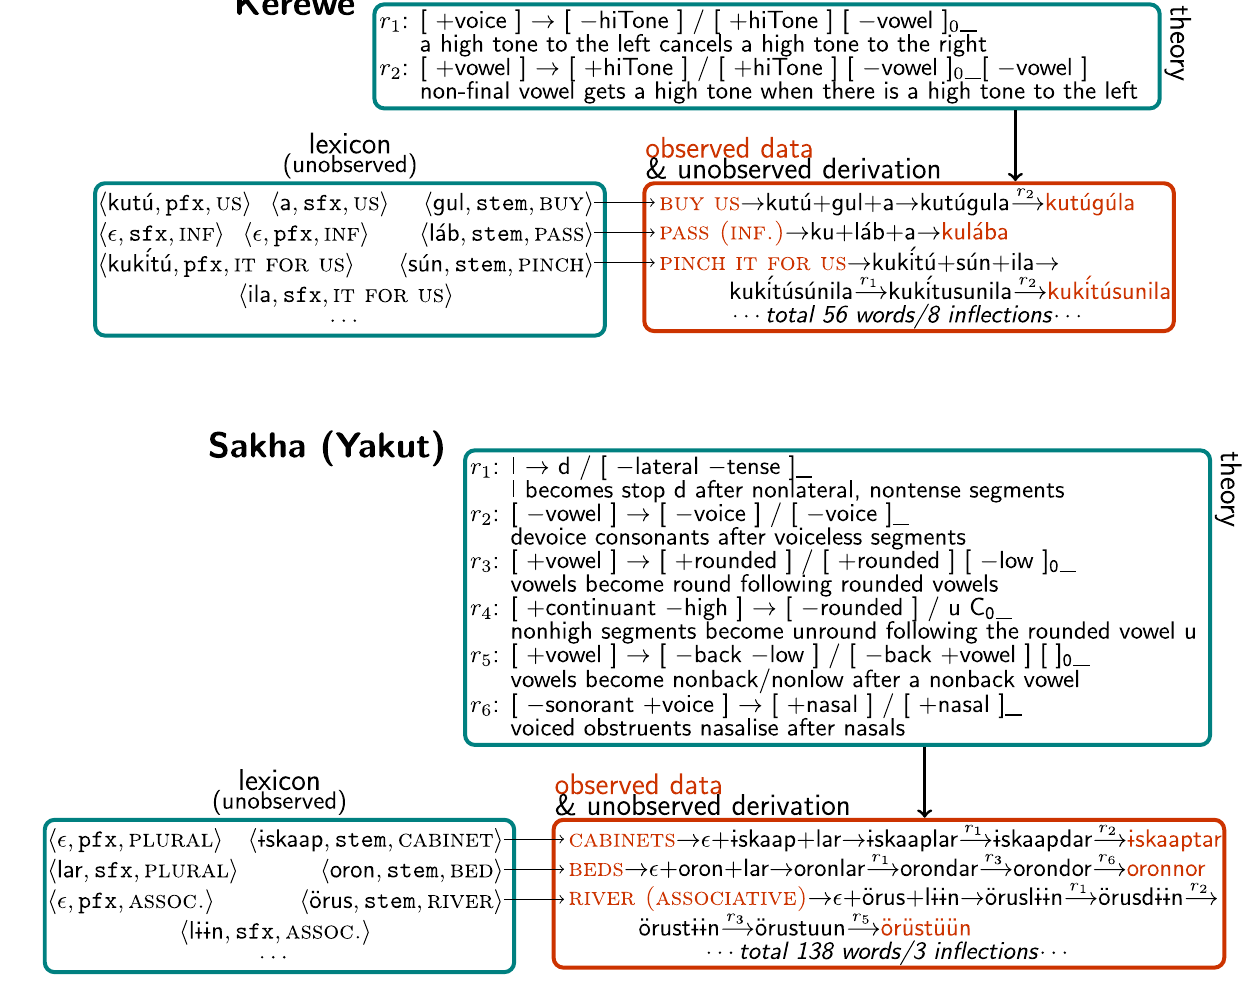
Fig. 4 | Qualitative results on morpho-phonological grammar discovery illu- strated on phonology textbook problems. The model observes form/meaning pairs(orange)andjointlyinfersbothalanguage-speci fi ctheory(teal;phonological rules labeled r 1 , r 2 , ...) and a data set-speci fi c lexicon (teal) containing stems and af fi xes. Together the theory and lexicon explain the orange data via a derivation wherethemorphologyoutput(pre fi x+stem+suf fi